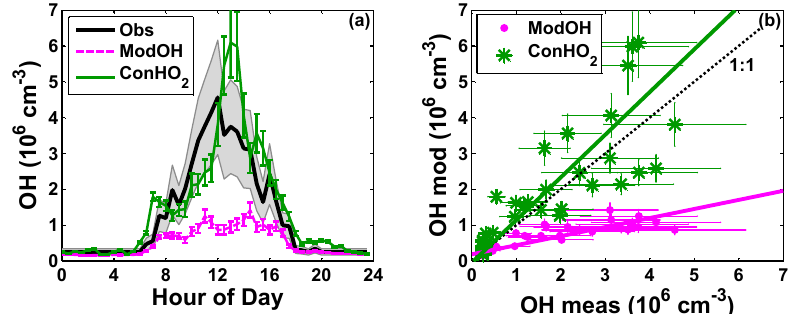
Fig. 7. Comparison of measured and modeled OH concentrations. (a) Diurnal profiles. Observations and their uncertainties are shown as a black line with gray shading. The ModOH results (magenta) are the same as those shown in Fig. 3. In the HO 2 -constrained case (green), HO 2 is constrained to “missing” HO ∗ as described in Sect. 5.1. The same uncertainties are assumed for both model scenarios. (b) Scatter plot of 2 the same results for ModOH (magenta dots) and HO 2 -constrained (green asterisks) scenarios. Thin lines define uncertainties in modeled and measured values. Thick lines represent uncertainty-weighted major-axis-regression fits (ModOH: y = 0 . 24 x + 0.18, r 2 = 0 . 81; ConHO 2 : y = 1 . 19 x – 0.05, r 2 = 0 .